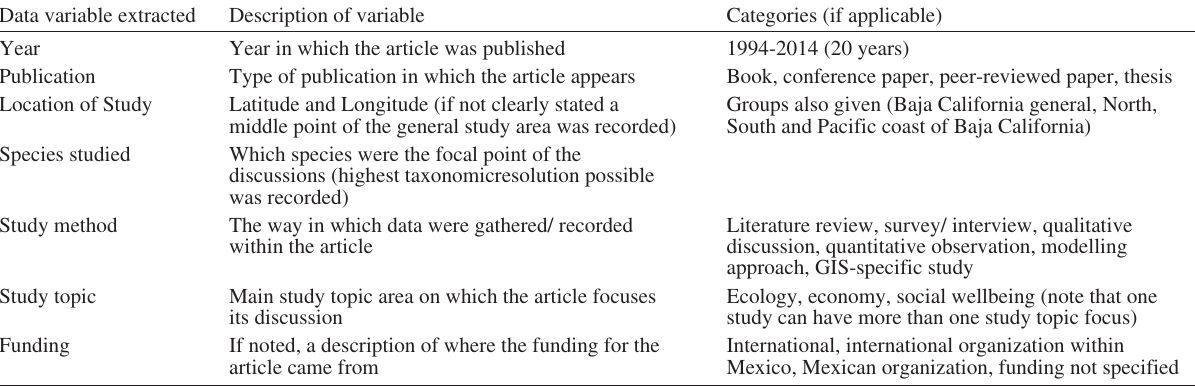
Table 1. – List of data variables extracted (where possible) from each publication selected by the literature review.